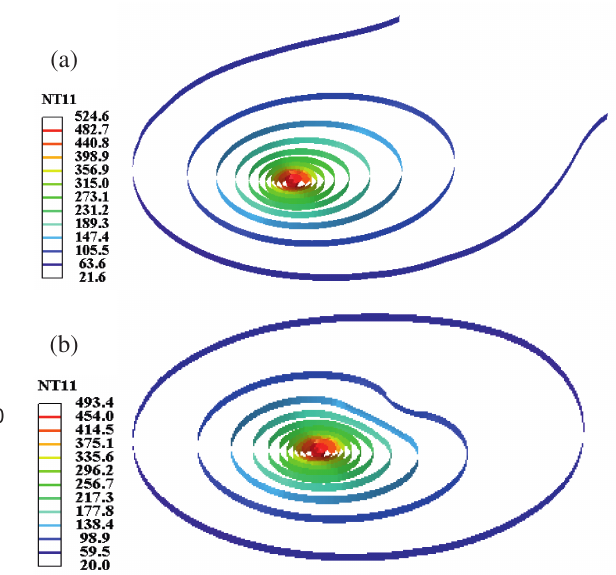
Figure 6: Temperature distribution of workpiece: (a) conventional cooling and (b)